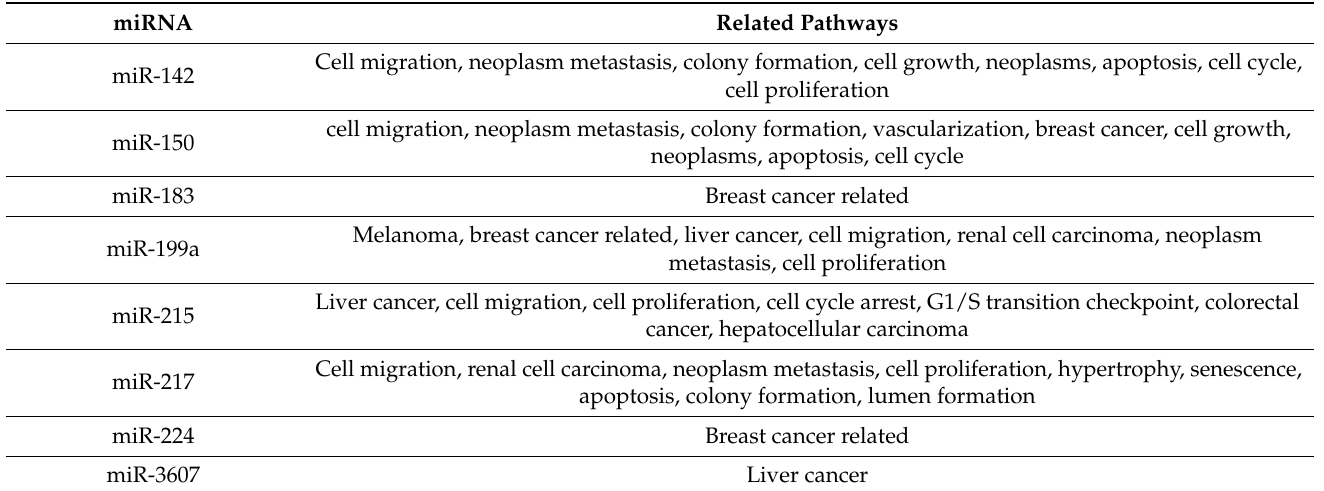
Table 9. Common pathways identified in DE-miRNAs.